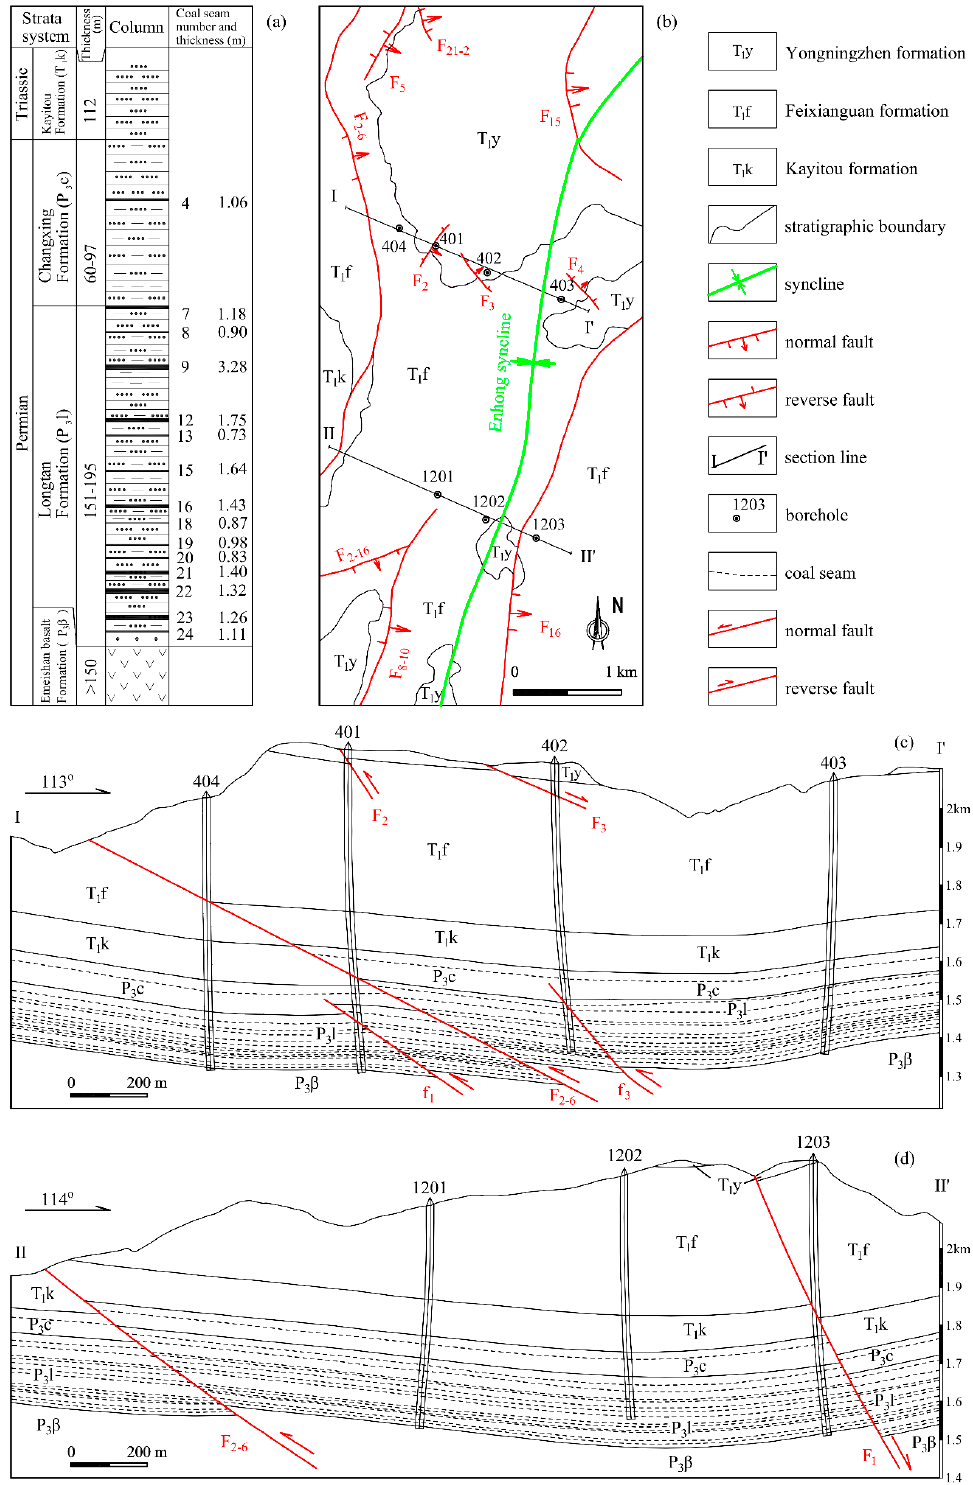
Figure 3. Stratigraphic column of coal-bearing strata ( a ), structural outline map ( b ) and structural cross sections ( c , d ) of Bumu region.